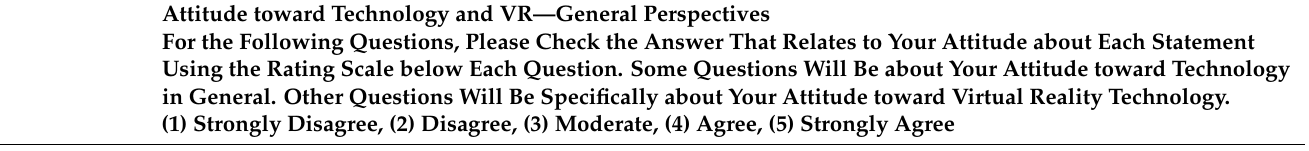
Table 5. Questions to examine students’ knowledge of